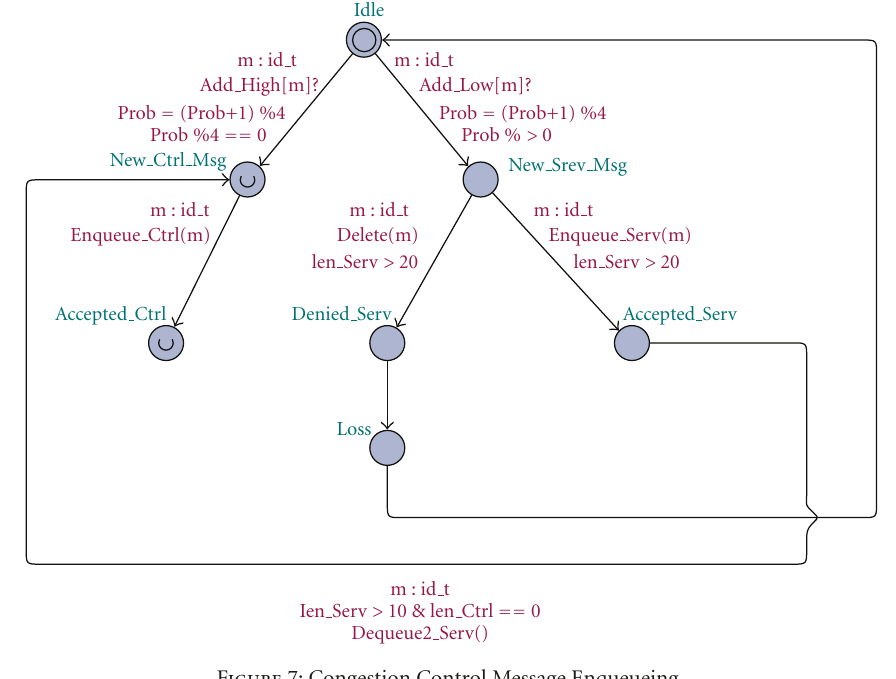
Figure 7: Congestion Control Message Enqueueing.